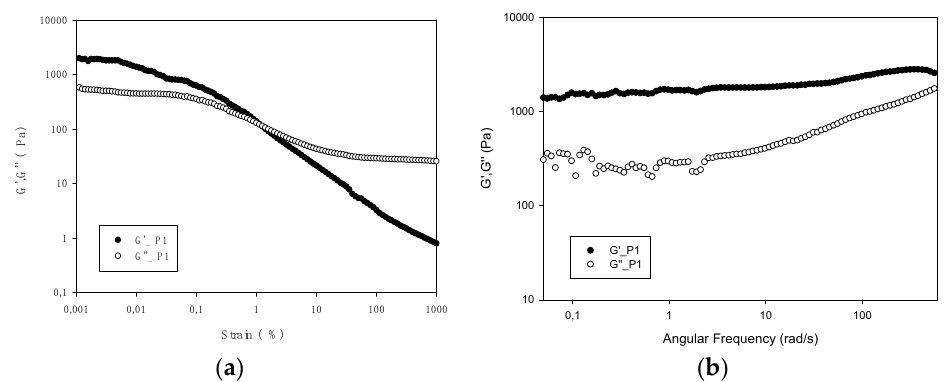
Figure 4. Strain and frequency sweeps for 30% solution ( w/v ) of salmon gelatin P1. Store (G ′ ; filled symbol) and loss moduli (G ′′ ; hollow symbol) depicted versus strain ( a ) and angular frequency ( b ).